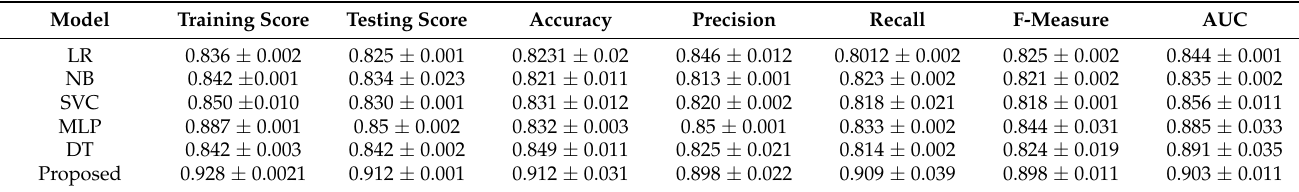
Table 4. Results of the prognosis model after 6 months.